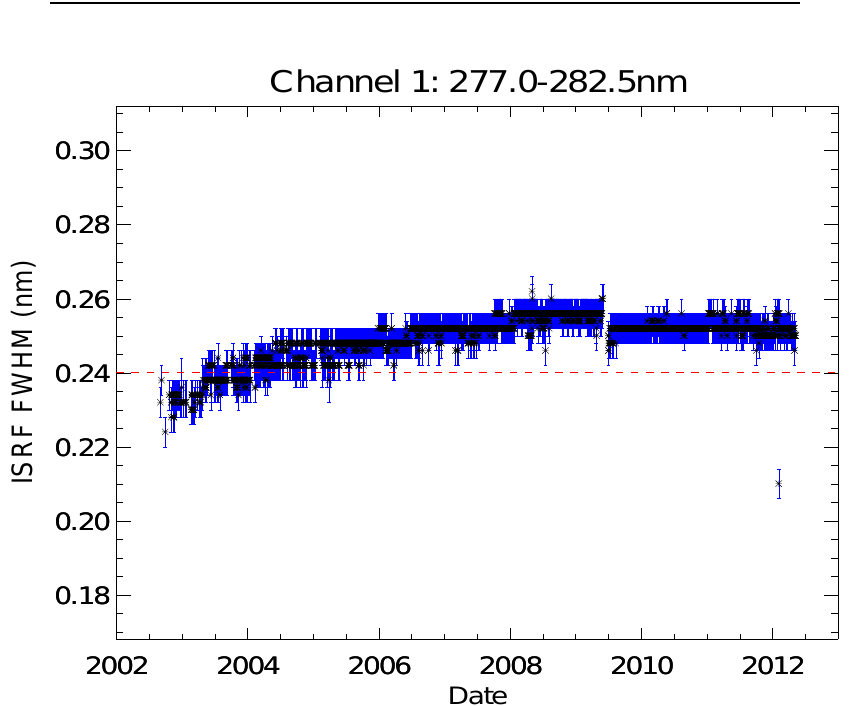
Figure 11. The ISRF’s FWHM, in nm, in Channel 1 as a function of time over the entire lifetime of SCIAMACHY. The marks (black asterisk) are the averaged FWHM of the retrieved ISRF, with their corresponding error bars (blue). The dashed red line identifies the estimated on ground one (Table